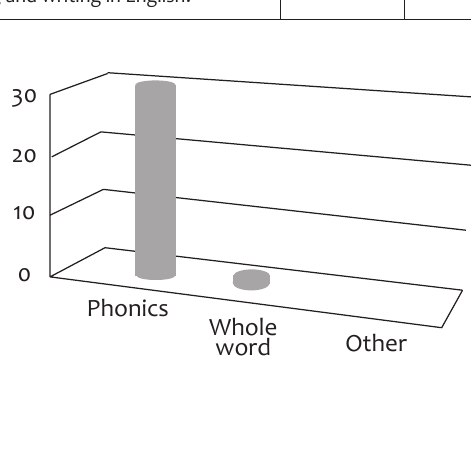
Table 5: Methods used for teaching reading in English Question 2. Which reading methods do you use